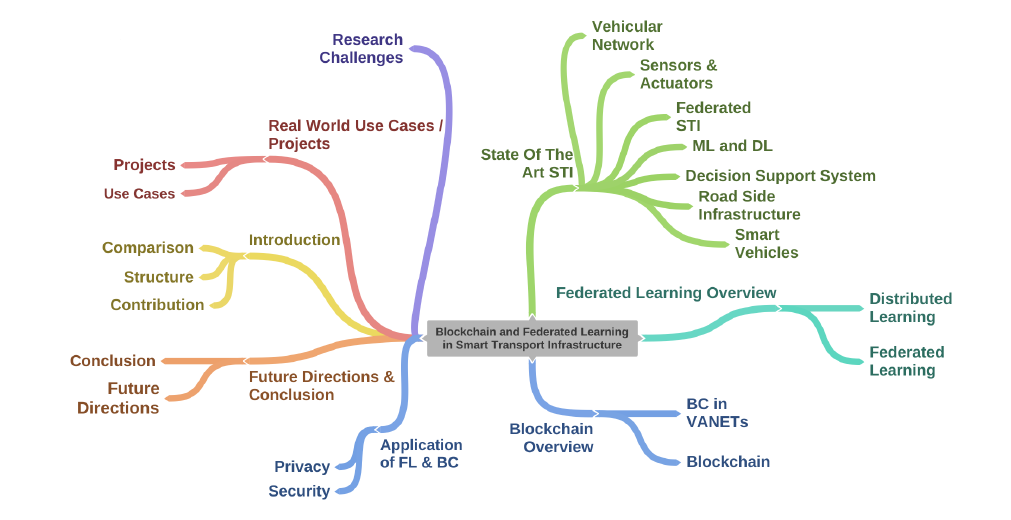
Figure 1. Structure of the proposed